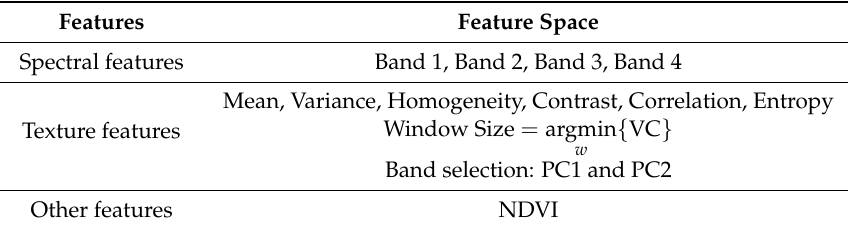
Table 2. Feature selection